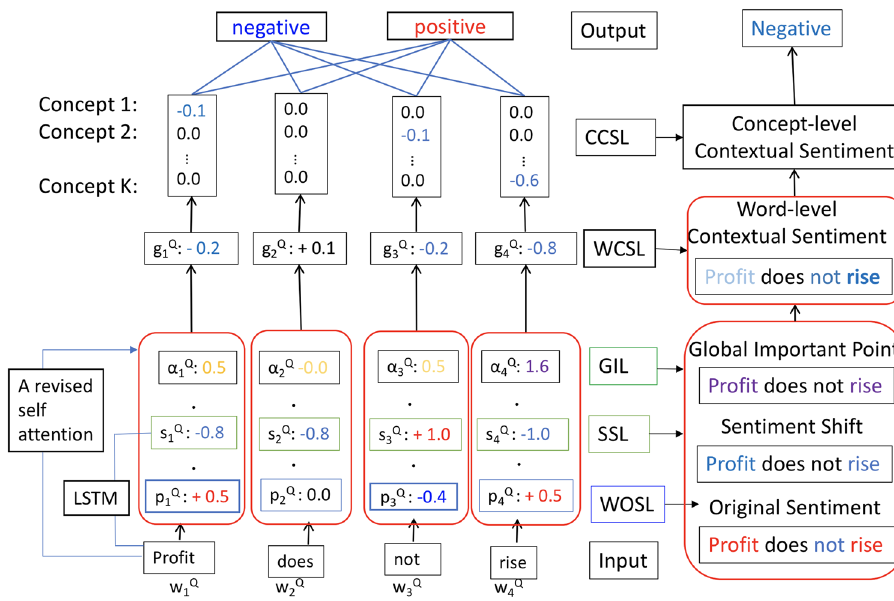
Fig. 2 Structure of